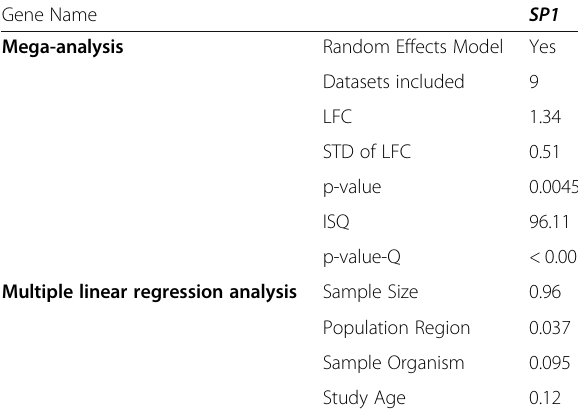
Table 2 Gene that passed the significant criteria for being involved in both DVT and